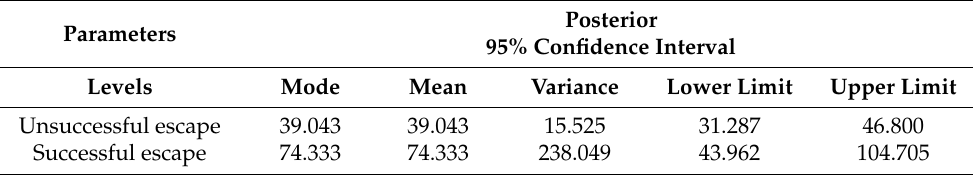
Table 9. Summary of descriptive statistics of the posterior distribution for the time from first attention to interaction or direct contact with the prey (seconds) covariate across hunting interaction success possibilities.